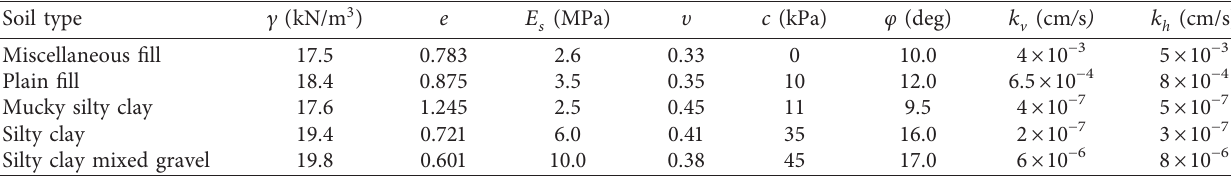
Table 1: Geotechnical properties of soil layers.